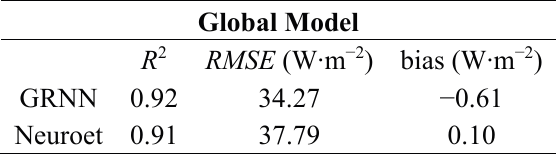
Table 5. Validation statistics for GRNN and Neuroet global